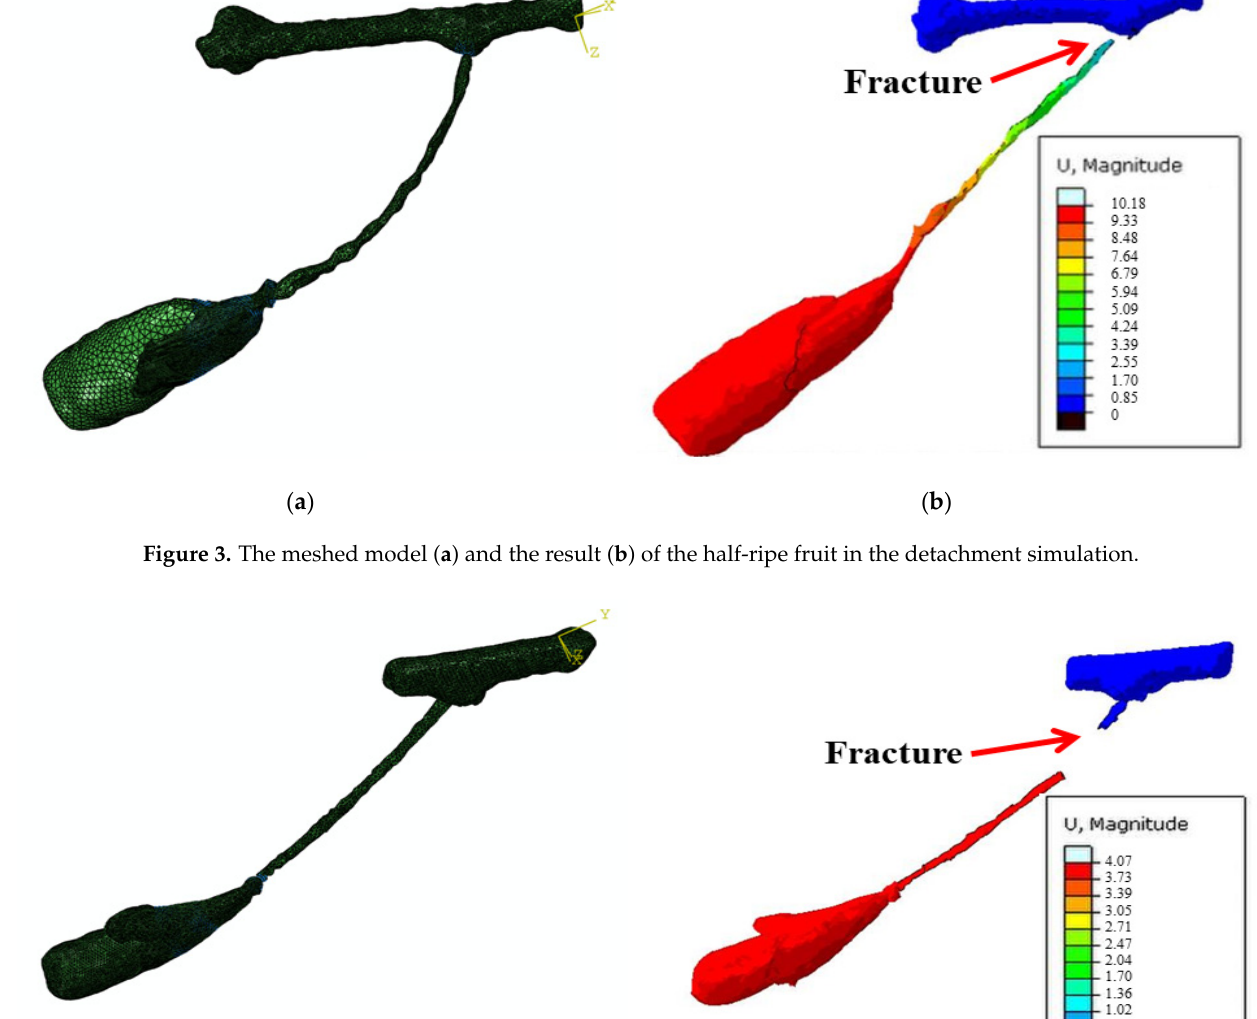
Figure 2. The meshed model ( a ) and the result ( b ) of the ripe fruit in the detachment simulation.